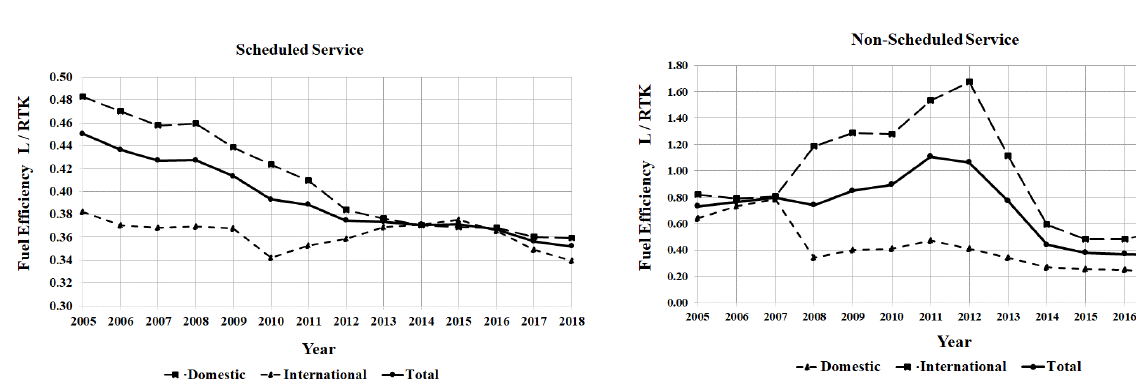
Figure 2. Domestic, international, and total Fuel Efficiency Values (Litres/RTK) for scheduled U.S. air carriers on an